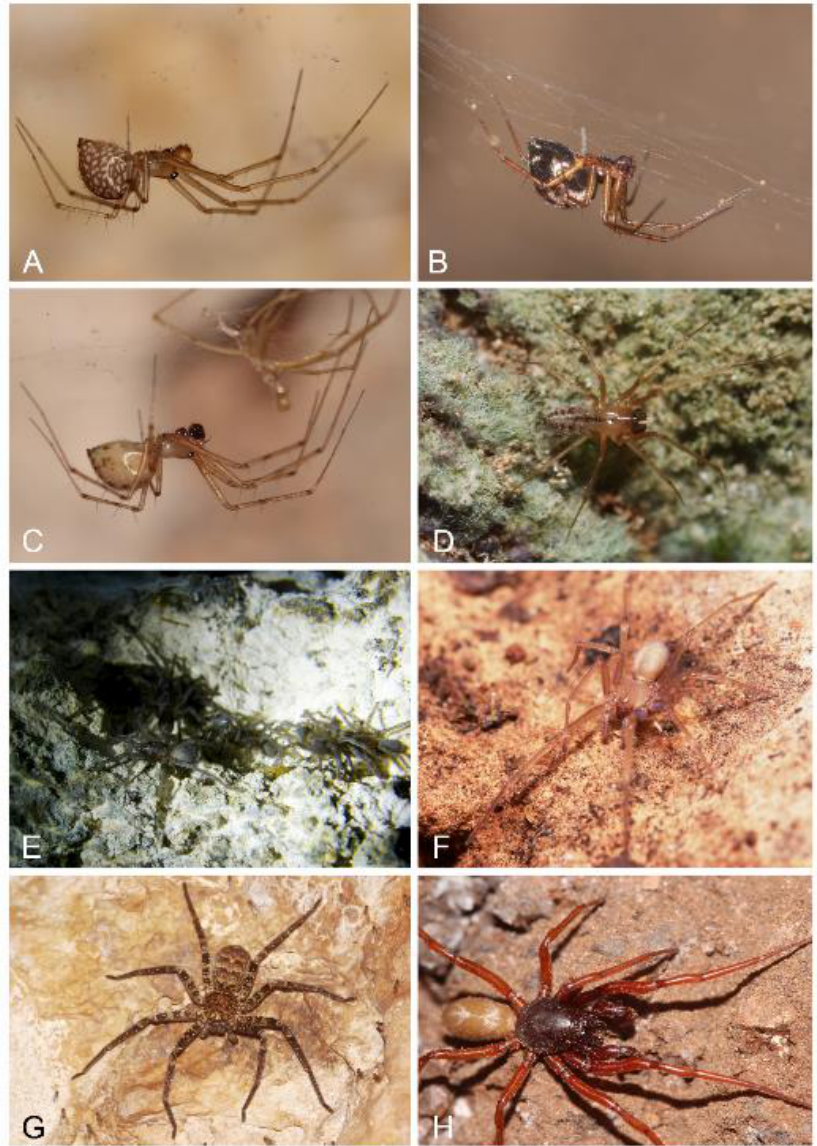
Figure 9. Additional troglophile spiders found during cave surveys. ( A – D ): Linyphiidae, Micronetinae: ( A ): Male micronetine sp. 1 form Besor medium cave (Negev desert, 32); ( B ): Male micronetine sp. 6 from Teomim large cave (Judean mountains, 24); ( C ): Male micronetine sp. 1? from Bet ‘Arif medium cave (western Samaria, 16); ( D ): Male micronetine from ‘Avedat cave (Negev desert, 33); ( E ): Chaetopelma Ausserer, 1871 (Theraphosidae) from Modi’in cave (Judea, not part of the survey); ( F ): Phyxelida anatolica Griswold, 1990 (Phyxelididae) from Haruva cave (HaShfela, 18); ( G ): Heteropoda variegata (Simon, 1874) (Sparassidae) from Yir’on large cave (upper Galilee, 2); ( H ): Harpactea Bristowe, 1939 (Dysderidae) from Ezba’ large cave (Karmel ridge, 12). Pictures: ( A – D ), ( F – H ): Shlomi Aharon, ( E ): Igor Armiach Steinptress.